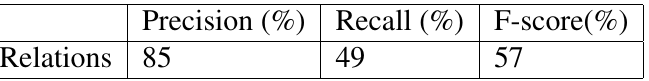
Table 4: Performance of relation extraction